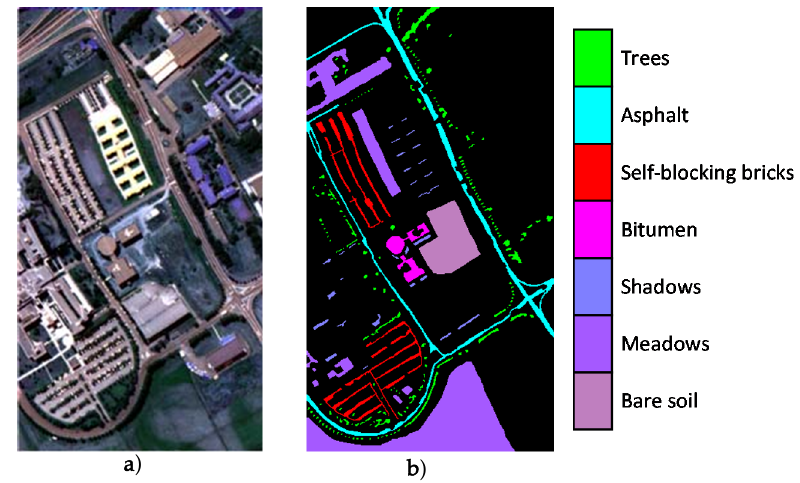
Figure 3. (a) False-color image of Pavia University dataset. (b) Ground truth of Pavia University Figure 3. ( a ) False-color image of Pavia University dataset. ( b ) Ground truth of Pavia University dataset.